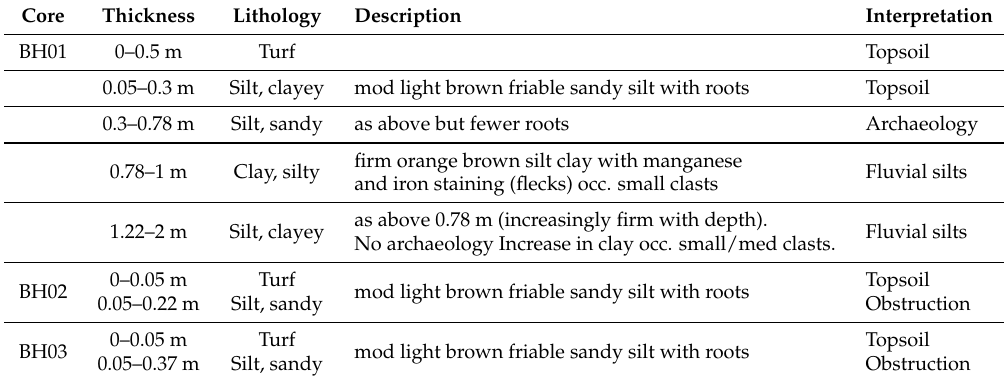
Figure 6. Core location over the magnetic response map. The areas highlighted in other figures are indicated. The transects 1 and 14 mentioned further are indicated in yellow dashed lines. Table 2. Description of cores BH1, BH2 and BH3. Occ: Occasional ; Mod: Moderate ; Med: Medium